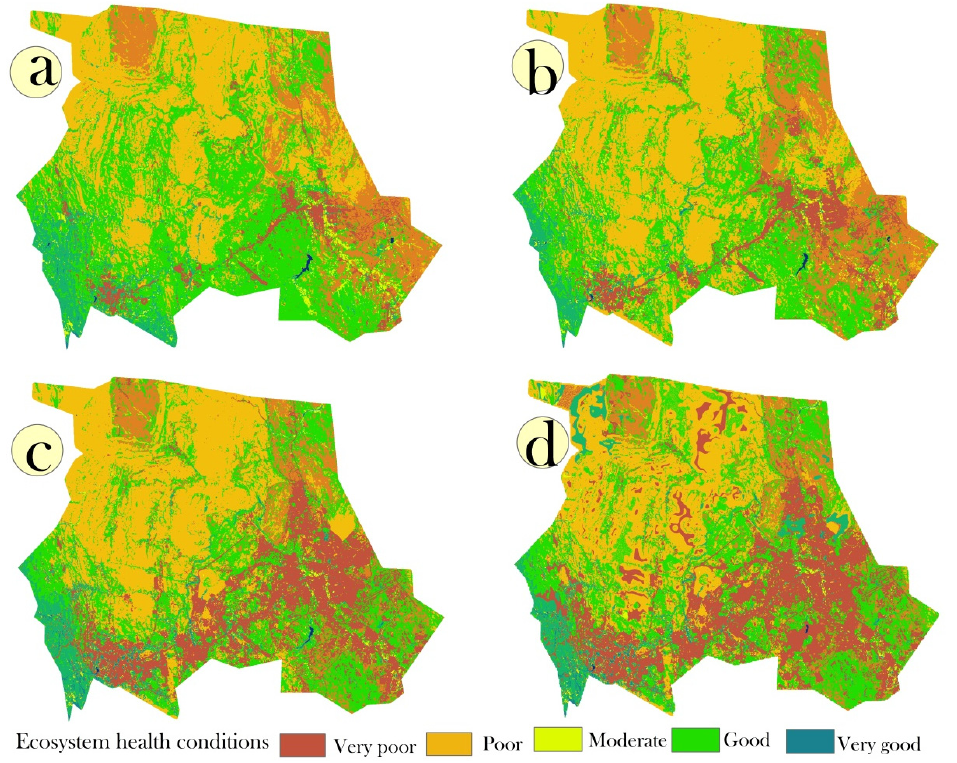
Figure 6. Ecosystem health conditions for ( a ) 1990, ( b ) 2000, ( c ) 2018, and ( d ) 2028.